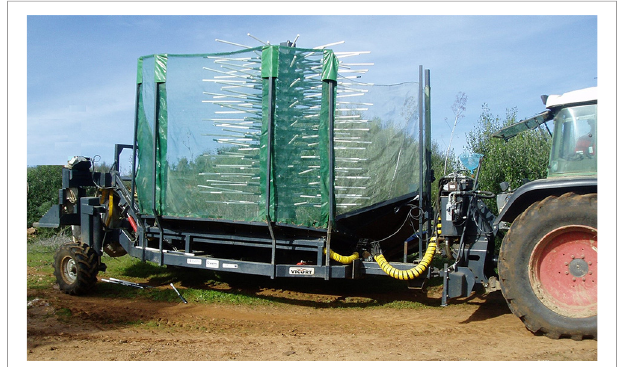
FIGURE 2 | Row side continuous canopy shaker.